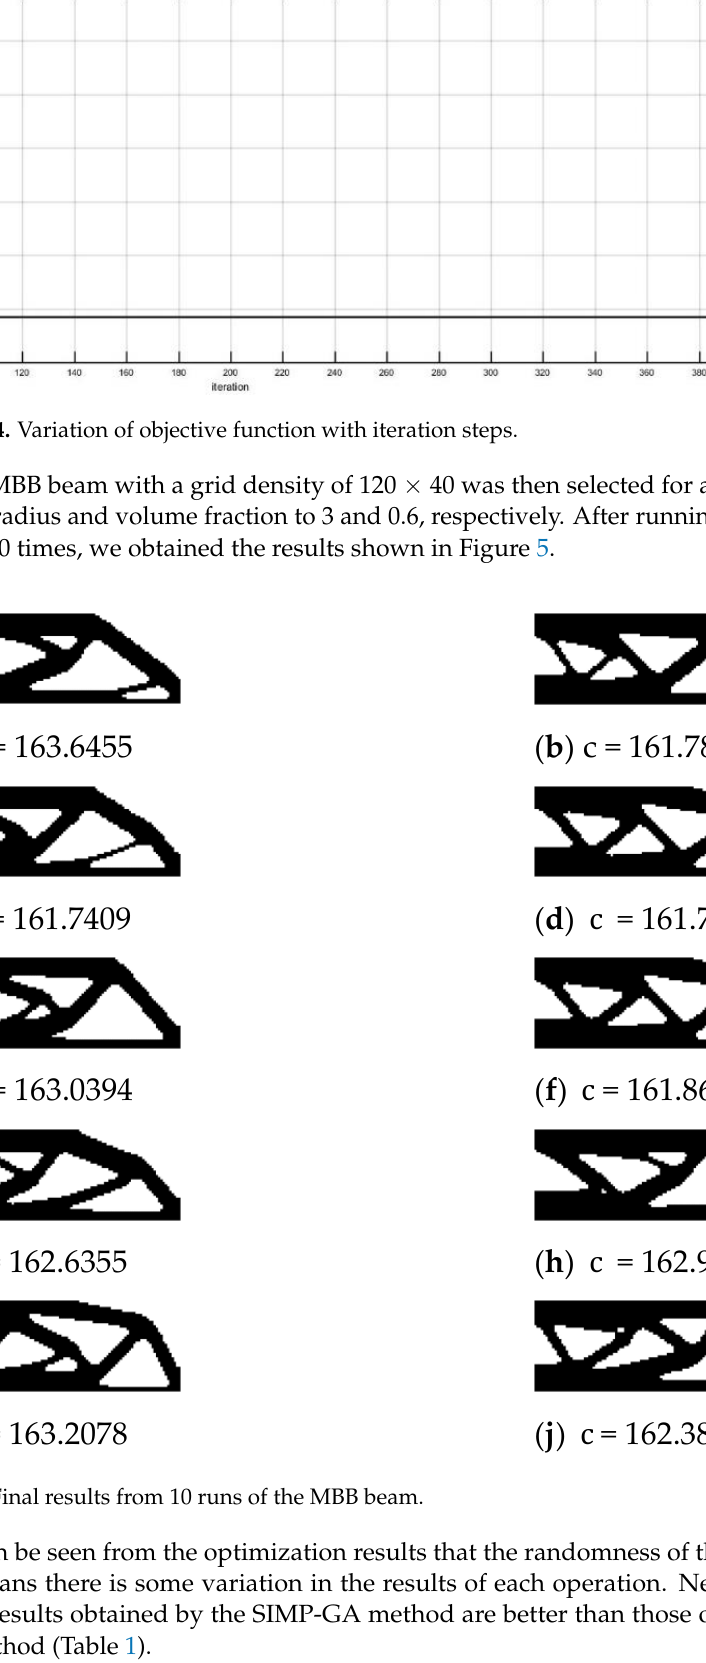
Table 1. Comparison of MBB beam optimization results.